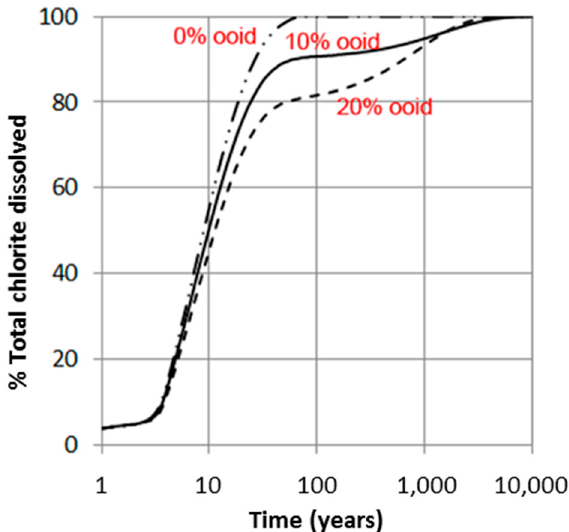
Figure 6. Simulated dissolution of chlorite (chamosite) (e.g., Johansen Formation, 96 °C, 300 bar CO 2 ); where chlorite was separated into two parts: (1) highly reactive pore filling/grain coating chlorite with large reactive surface area (1 µm grains); and (2) low-reactive ooids (125 µm aggregates where reactions are only assumed on the aggregate surface). Up to 20% chlorite in ooids was simulated.